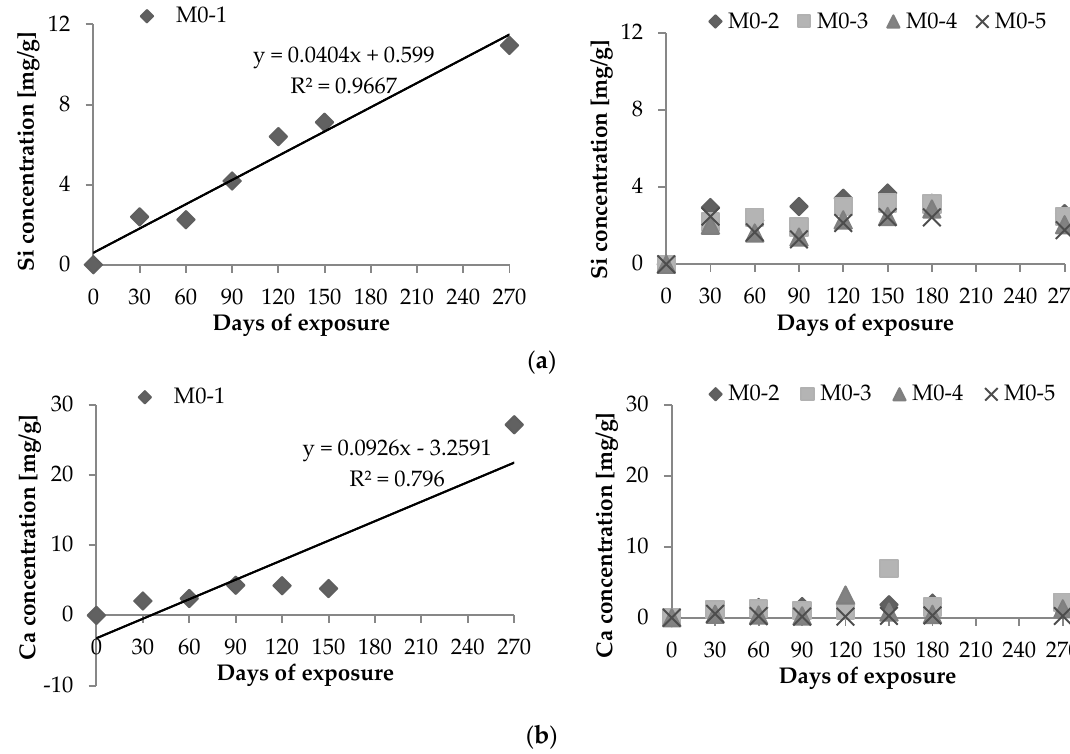
Figure 1. Dissolved: ( a ) Si 4+ and ( b ) Ca 2+ corresponding to 1 g of concrete samples without the addition of silica fume.